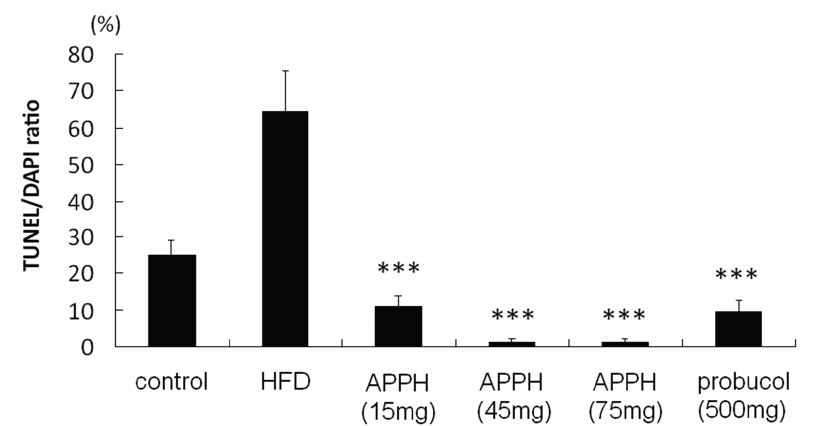
Figure 4. DAPI and TUNEL staining analysis. Cell nuclei were stained blue using DAPI on the heart biopsy slides, and specific DNA fragments in apoptotic cell nuclei were stained green using TUNEL (Bar length = 100 μ m). The percentage of apoptosis cells is presented as the TUNEL/DAPI ratio. *** p < 0.001 compared with the HFD (high-fat diet)